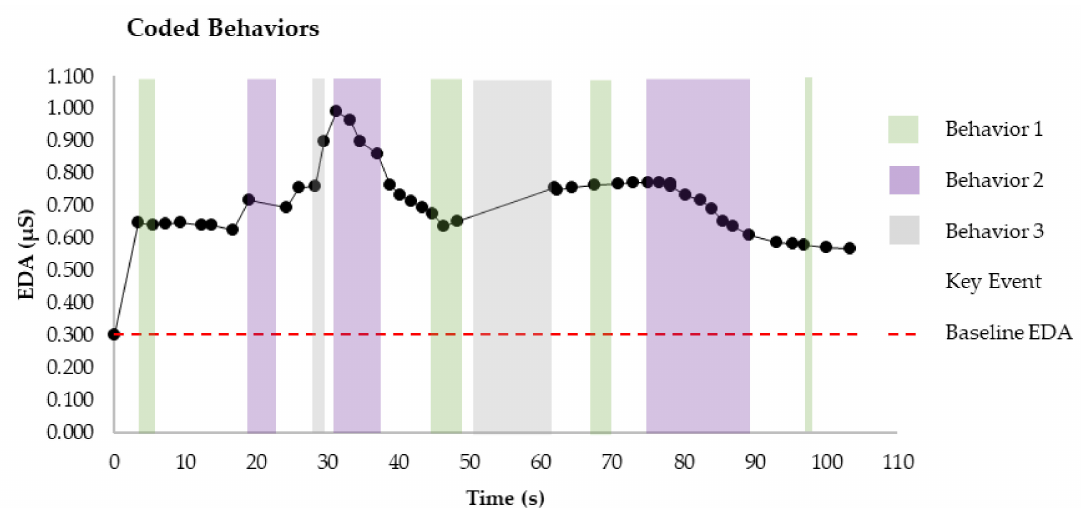
Figure 4. Exploring behaviors of individuals relative to